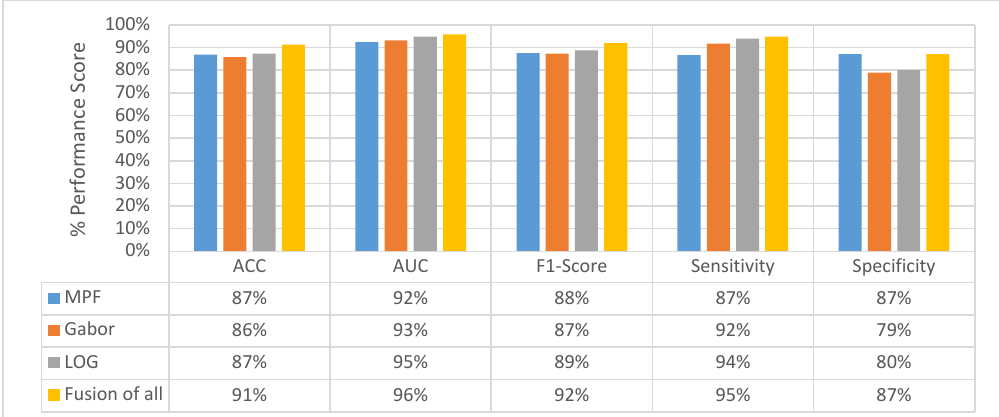
Figure 39. Change in final layer classification performance of MPF, SFMPF based on Gabor and LOG, and MFMPF models.